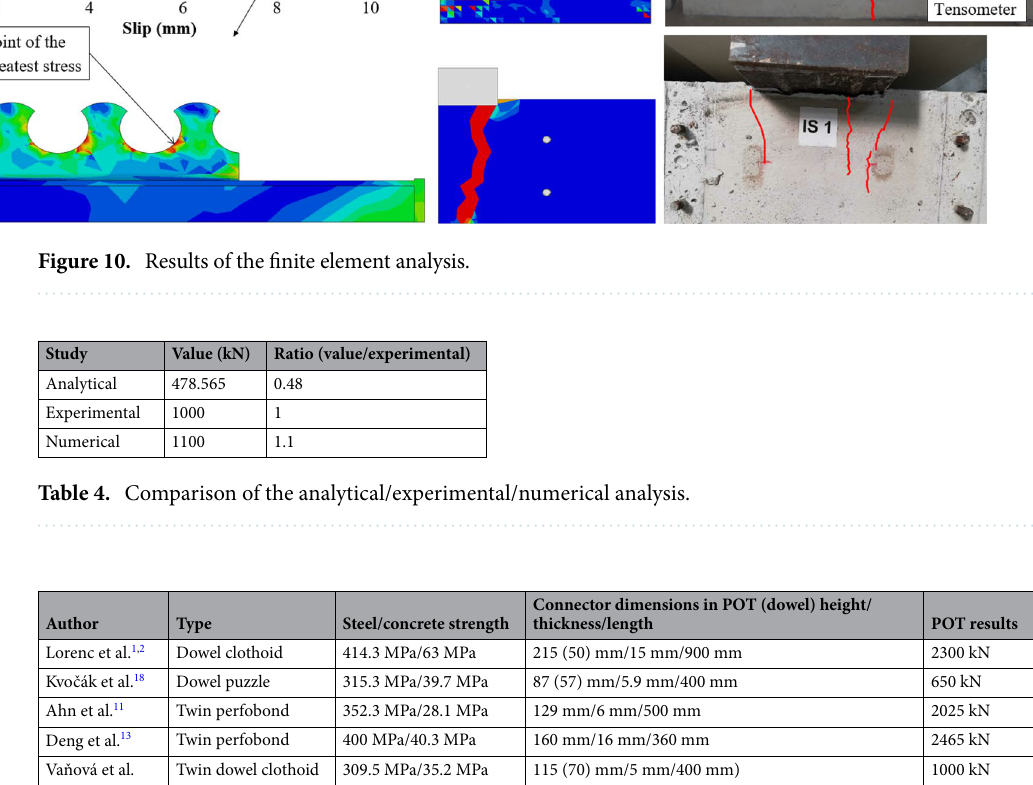
Table 5. Comparison with different